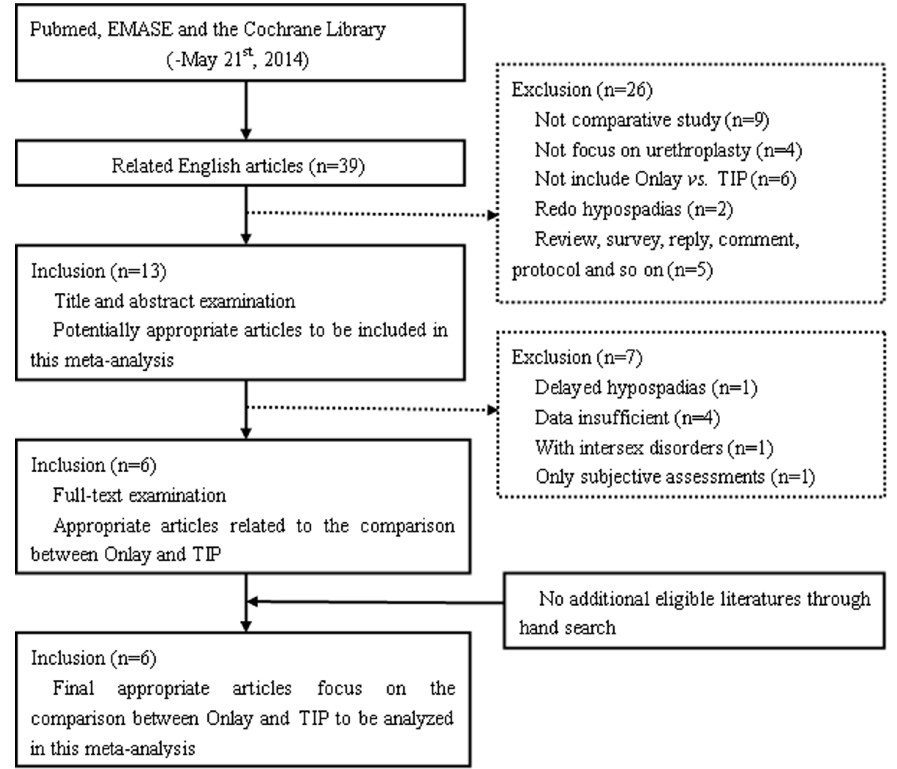
Figure 1. Flow diagram of eligible literatures identification from different medical databases.